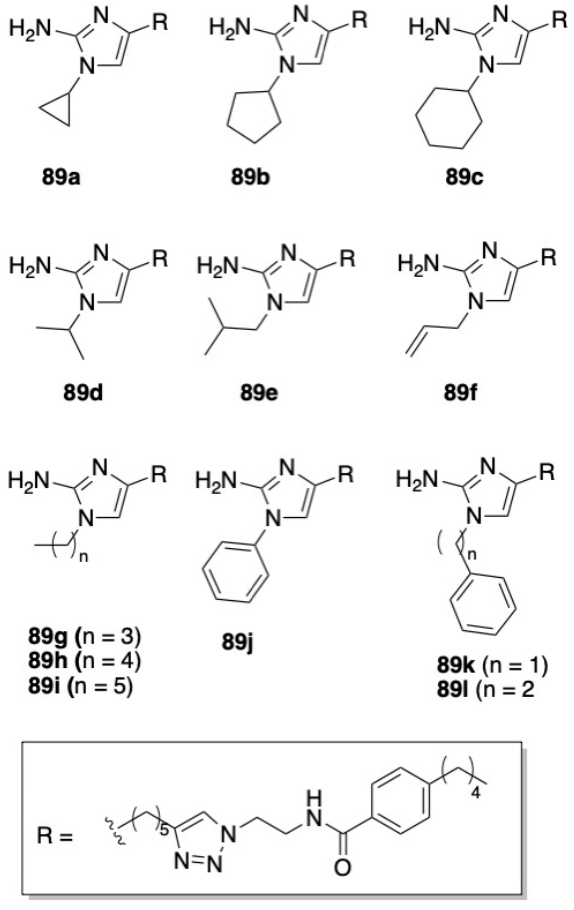
Figure 9. Triazoles 89a-l prepared by Furlani et al. [137] .